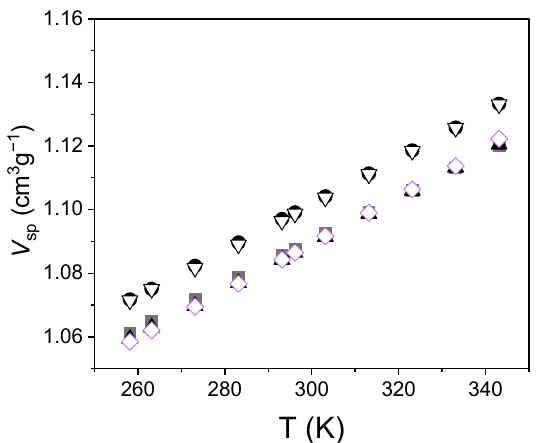
Figure 1. Specific volume V sp as a function of the temperature T in the investigated elastomers (S1: squares, S2: circles, S3: up triangles, S4: down triangles, S5: diamonds). Uncertainties are within the size of the data.